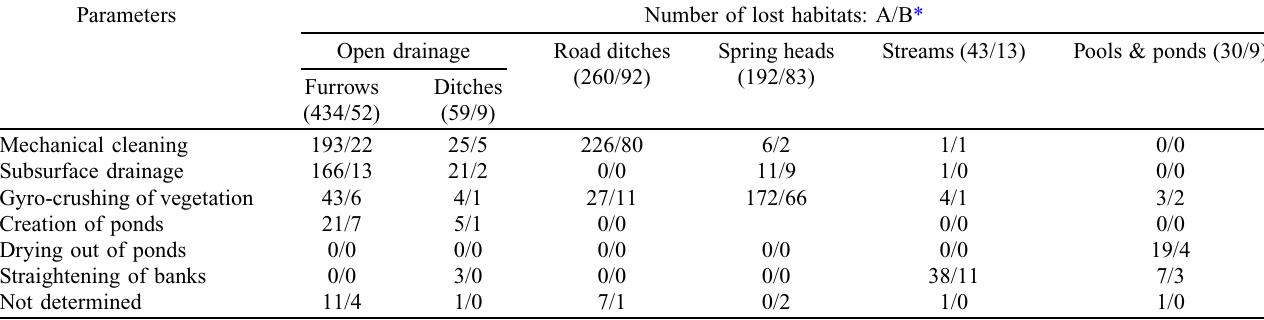
Table 7. Number of lost snail habitats in 2013–2016 in relation to the cause of population decline and the type of habitat. A/B, habitats colonized by Galba truncatula /sites inhabited by Omphiscola